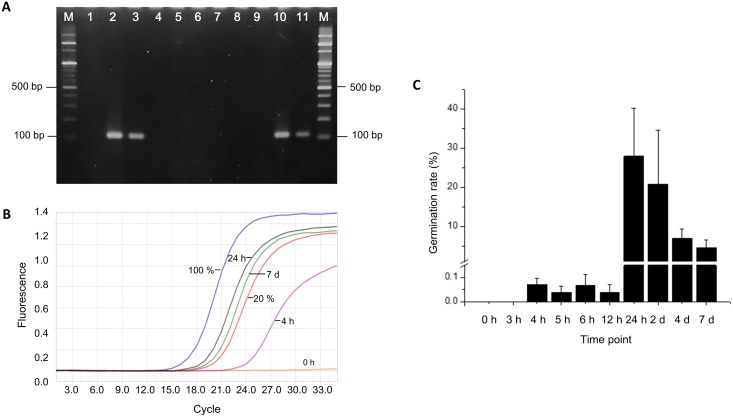
Expression of BaqA-SH6 mRNA in the gut of L. vannamei during 7 d feeding with SH6 spores.(A) Agarose-gel electrophoresis of 110 bp PCR product specific for BaqA-SH6 gene using specific primers and DNA templates extracted from different samples. Lane 1: water only-negative control; lane 2, 3: bacterial cells of B. aquimaris SH6; lane 4: B. subtilis PY79; Lane 5: B. indicus HU36; Lane 6: B. aquimaris SH1 (Accession No. KF443805); lane 7: B. marisflavi SH8 (Accession No. KF443806); lane 8, 9: shrimp gut from negative control; lane 10, 11: shrimp gut from SH6-spore M/L groups; M: 100 bp DNA ladder. (B) Shrimp was fed with SH6 spores at 1 × 108 CFU/g pellet. RNA was extracted from shrimp gut at 0h, 3 h, 4 h, 5 h, 6 h, 12 h, 24 h, 2 d, 4 d, 7 d after spore administration, and then was used as templates for real-time RT-qPCR measuring mRNA expression of the 110 bp sequence of BaqA-SH6. Representative amplification curves using RNA extracted at time points: 0, 4, 5, 6, 12, 24 h, 2 d, 4 d and 7 h in comparison to positive controls of 20% germination. (C) Germination levels (%) of SH6 spores in shrimp gut at different time points after spore administration.